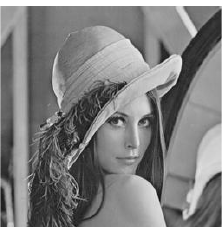
Mathematics 2019 , 7 , x